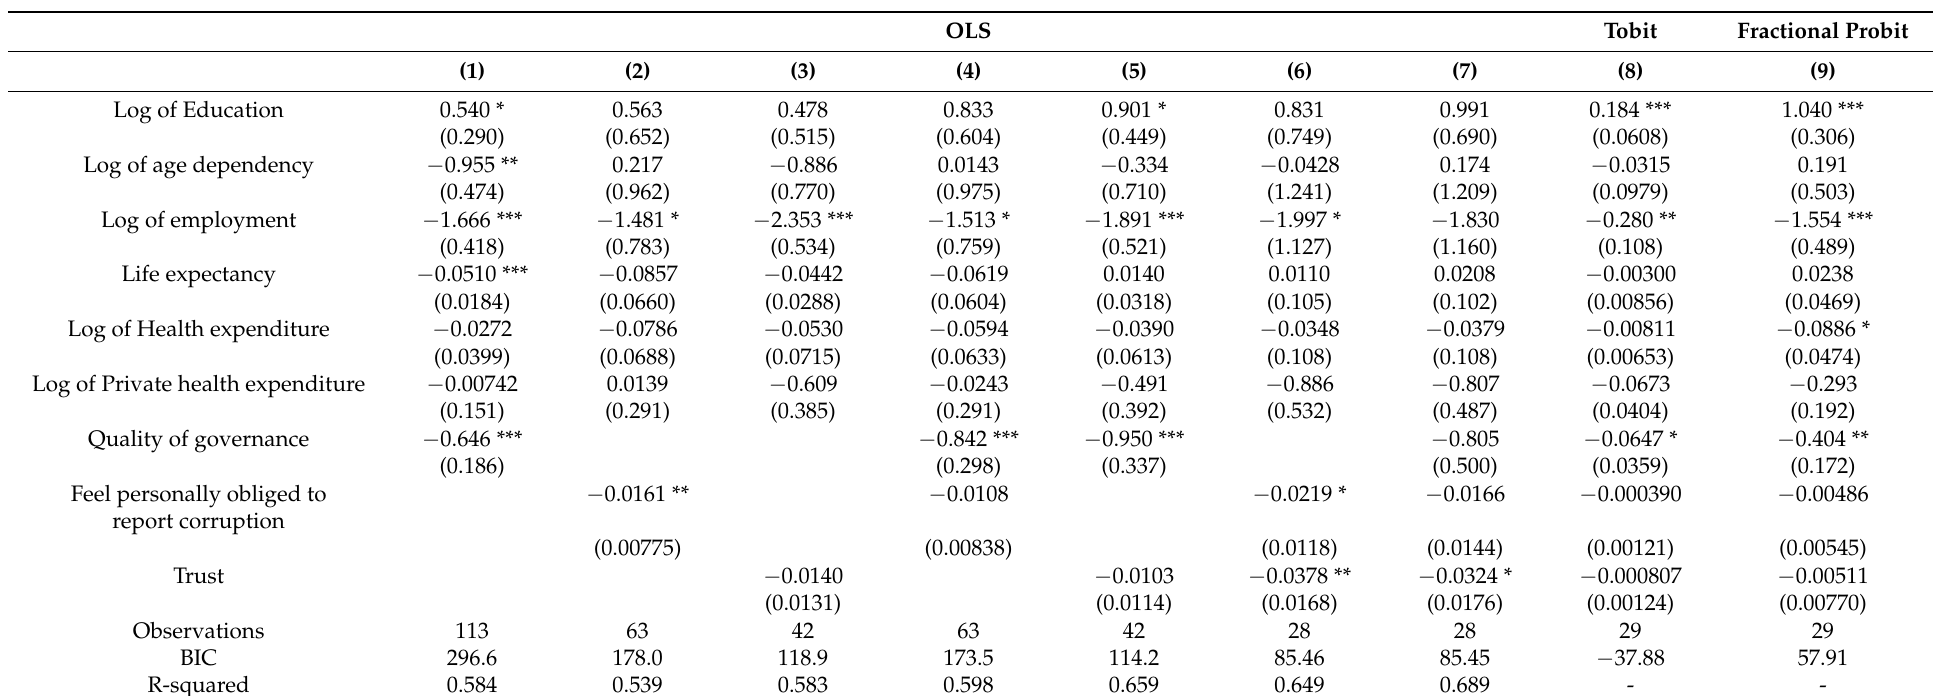
Table 2. Cross-section estimation of the role of formal and informal institutions in explaining informal payments in health